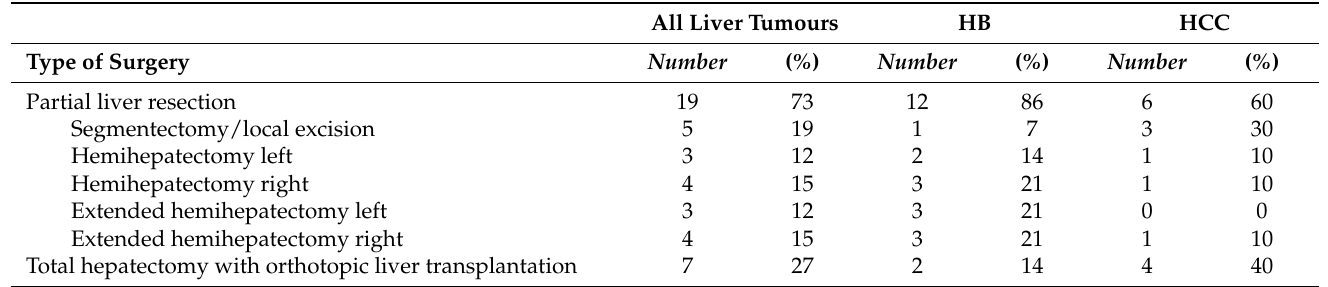
Table 2. Overview of surgical procedures for paediatric liver